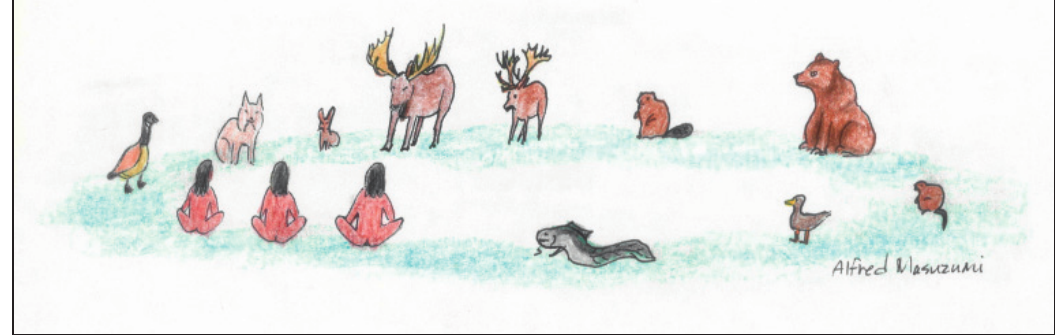
Fig. 1. Meeting of caribou and wolves. Credit: Alfred